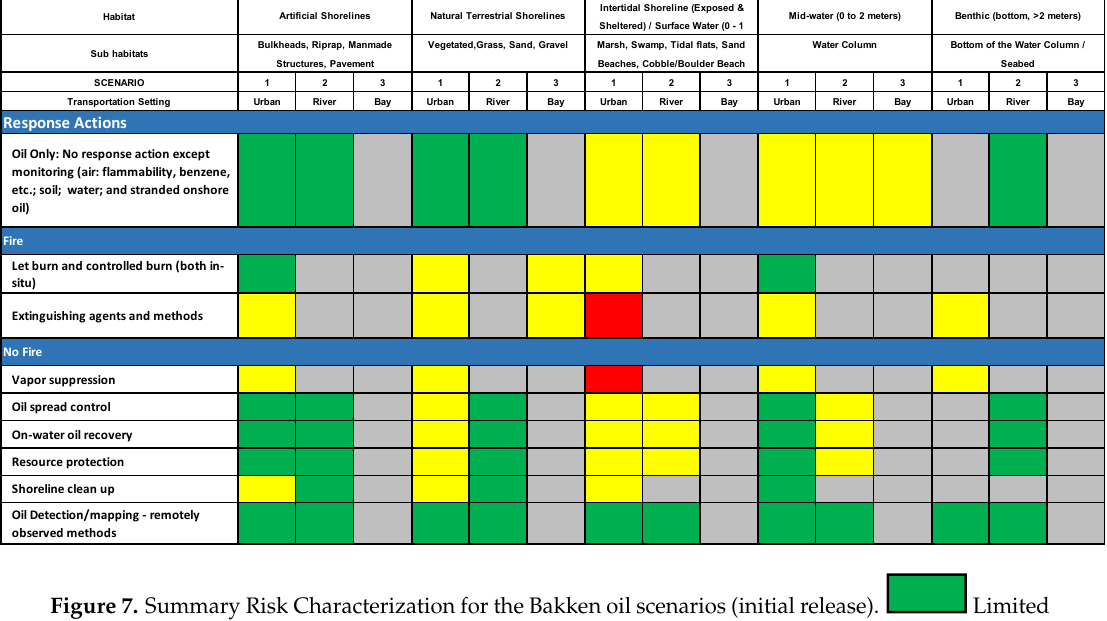
Figure 7. Summary Risk Characterization for the Bakken oil scenarios (initial release). Figure 8. Summary Risk Characterization for the Bakken oil scenarios (weathered). Limited Level of Concern;